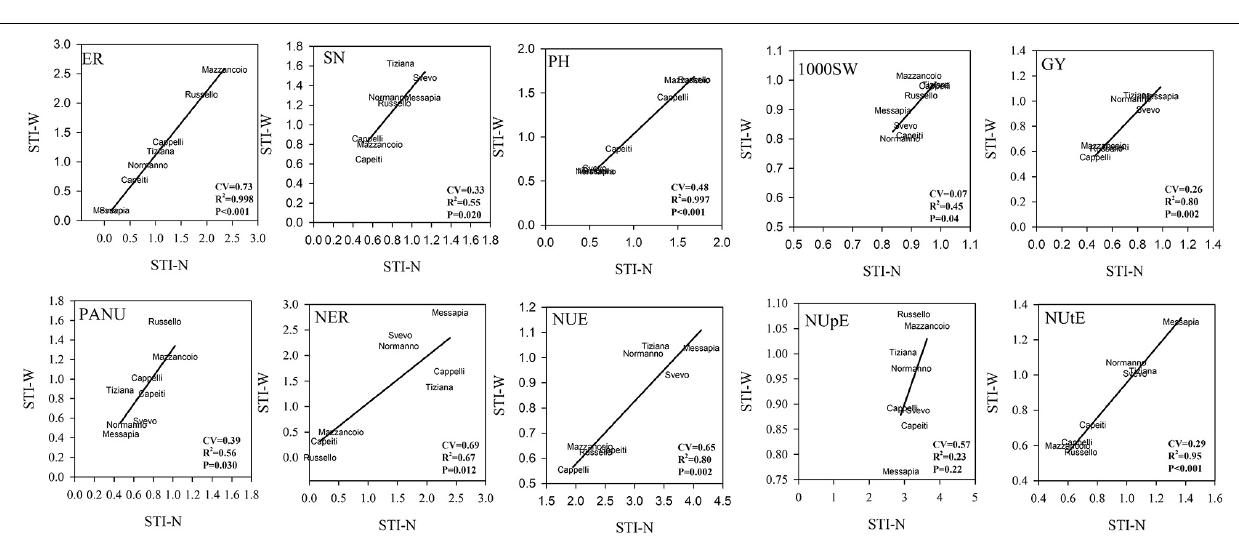
and group 2 (G2), were identified as previously reported for some traits in the biplot (see Figure 4 ). The G1 included the modern varieties Messapia, Tiziana, Svevo, and Normanno,